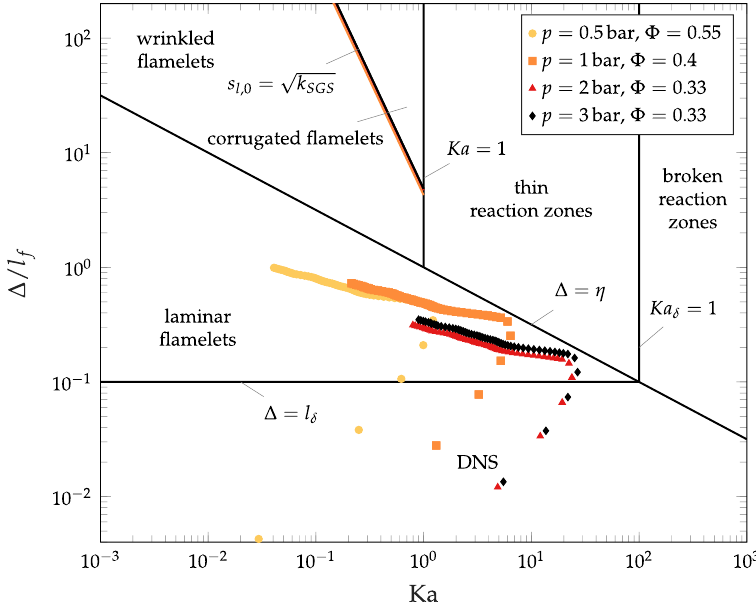
Figure 2. LES combustion regimes for U b = 10ms − 1